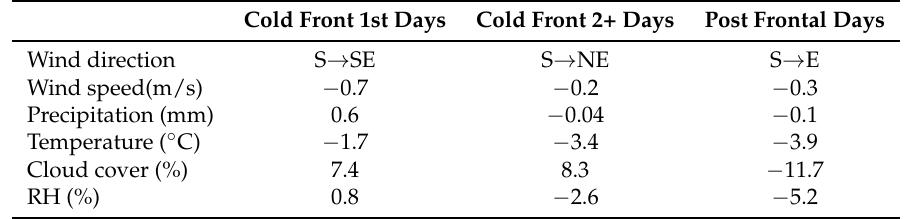
Table 1. Median difference of meteorology compared to no front days.